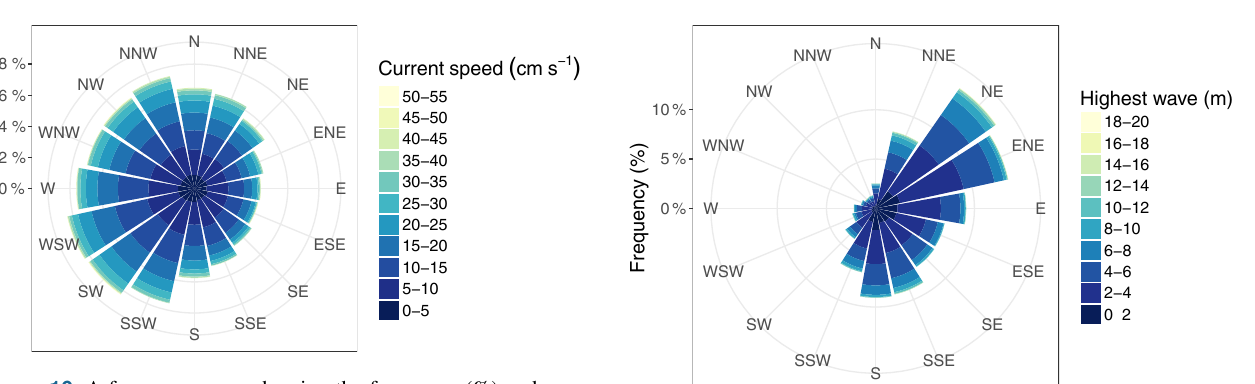
Figure 10. A frequency rose, showing the frequency (%) and cur- rent speed (cms − 1 ) for different current directions (22.5 ◦ bins) at 4m height. Note that current direction is defined as the direction the current is streaming toward, which is opposite to the convention of wind direction.